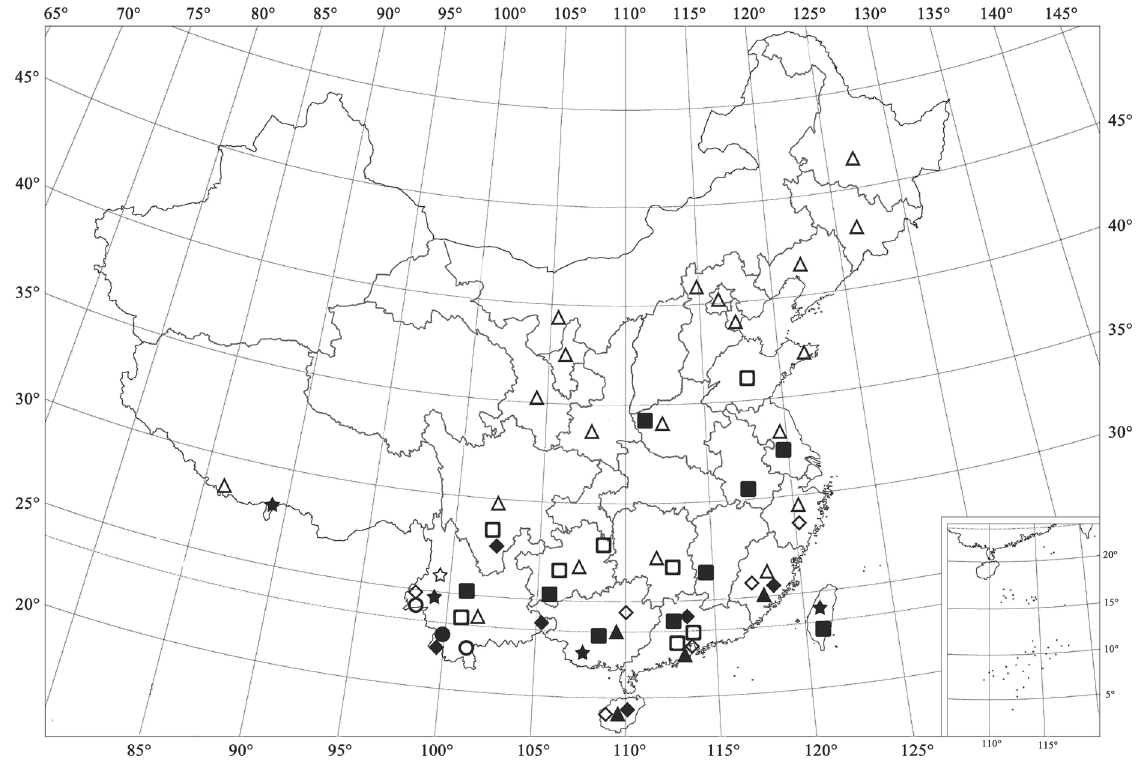
Fig. 21. Distribution map. ( ) = Chilocorus politus Mulsant, 1850; ( ) = C. yunlongensis Cao & Xiao, 1984; (●) = C. nigricaeruleus Li & Wang sp. nov.; (○) = C. nigrita (Fabricius, 1798); (▲) = C. melas Weise, 1898; ( ) = C. rubidus Hope, 1831; (■) = C. chinensis Miyatake, 1970; (□) = C. rufitarsis Motschulsky, 1853; ( ) = C. hauseri Weise, 1895; ( ) = C. circumdatus (Gyllenhal,